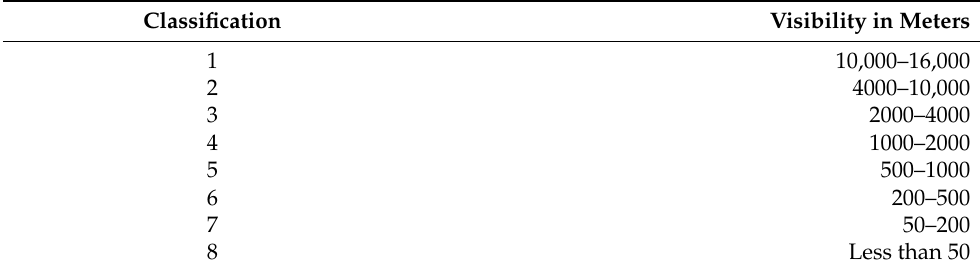
Table 4. Exemplary classification of visibility according to [22], which is used to measure the influences of dust and fog.